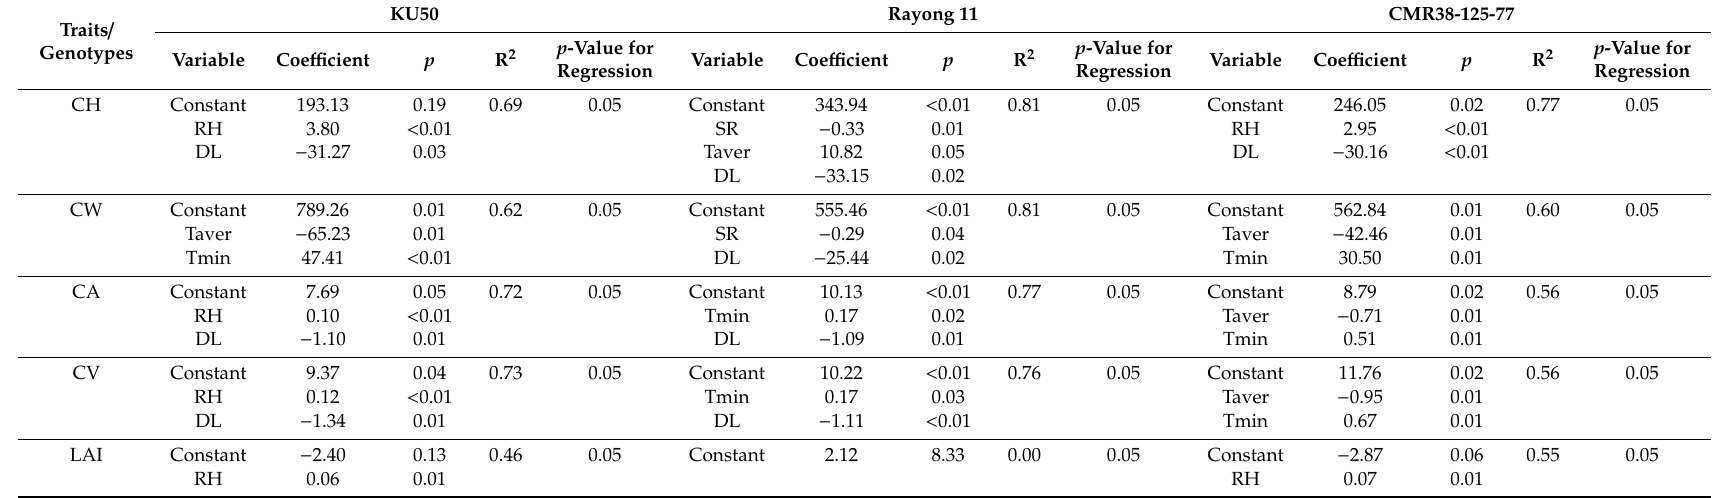
Table 5. Stepwise regression analysis for canopy traits and climatic factors for three cassava genotypes planted in May